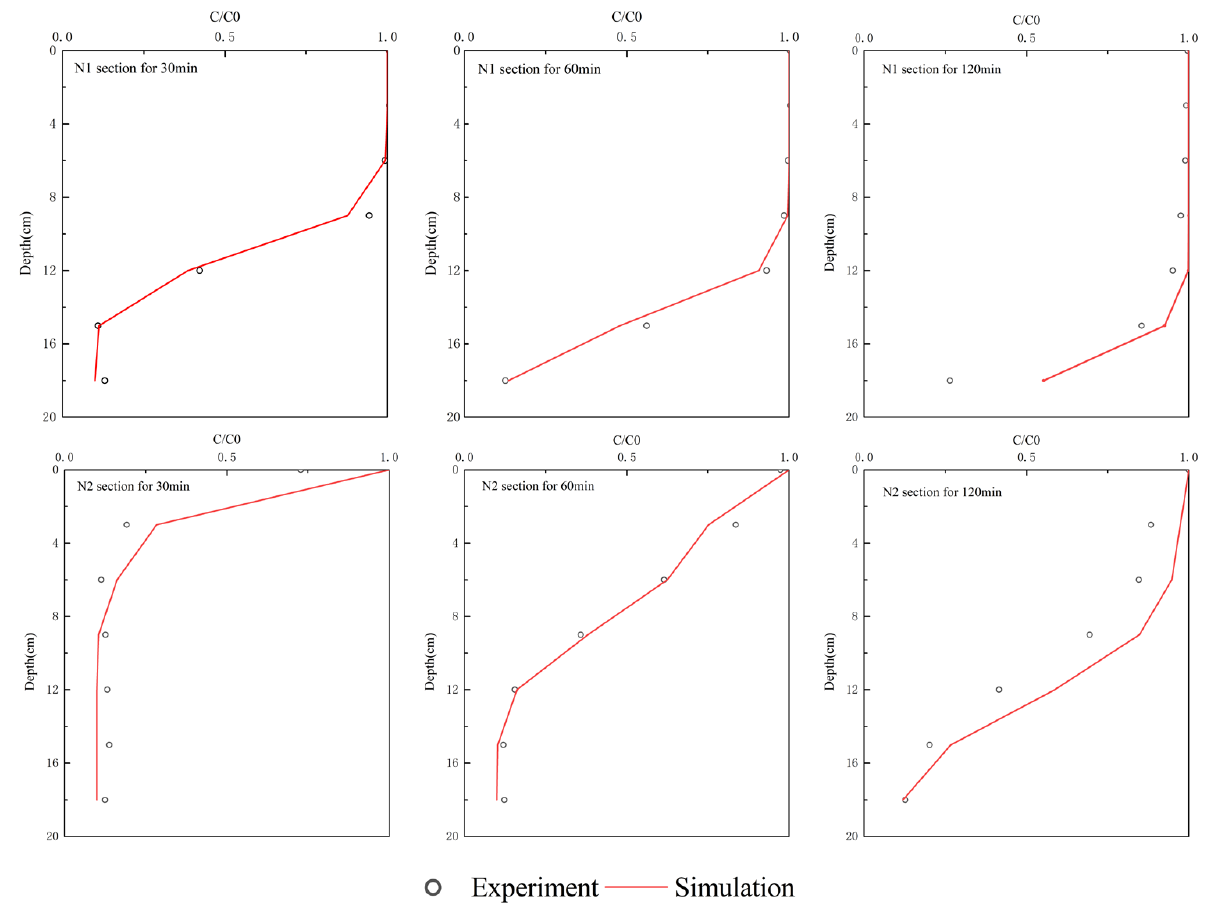
Figure 3. Comparison between the experiment and simulation for NaCl concentrations in different depths and times at N1 and N2 sections.